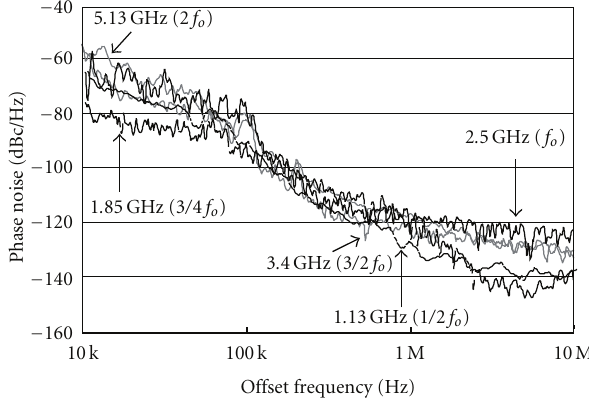
Figure 10: Phase noise at f 0 (2.50GHz) and 3 / 4 f 0 (1.85GHz).